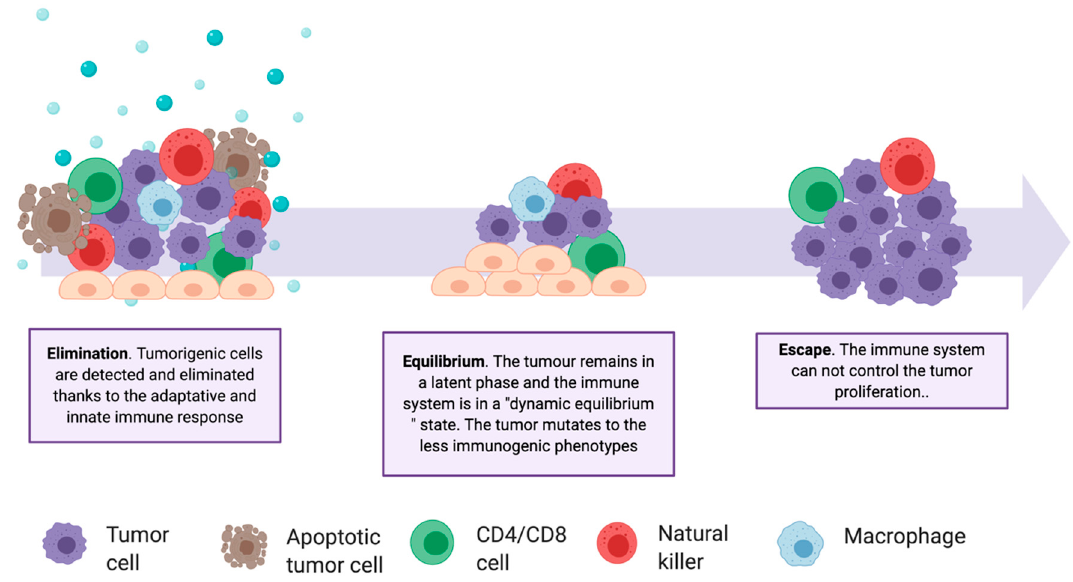
Figure 5. The complexity of the tumor–immune system relationship. Schematic representation of the three phases of the Immunoediting Theory and of the involved cell types. Tumor heterogenicity increases through the elimination phase, selecting the less immunogenic